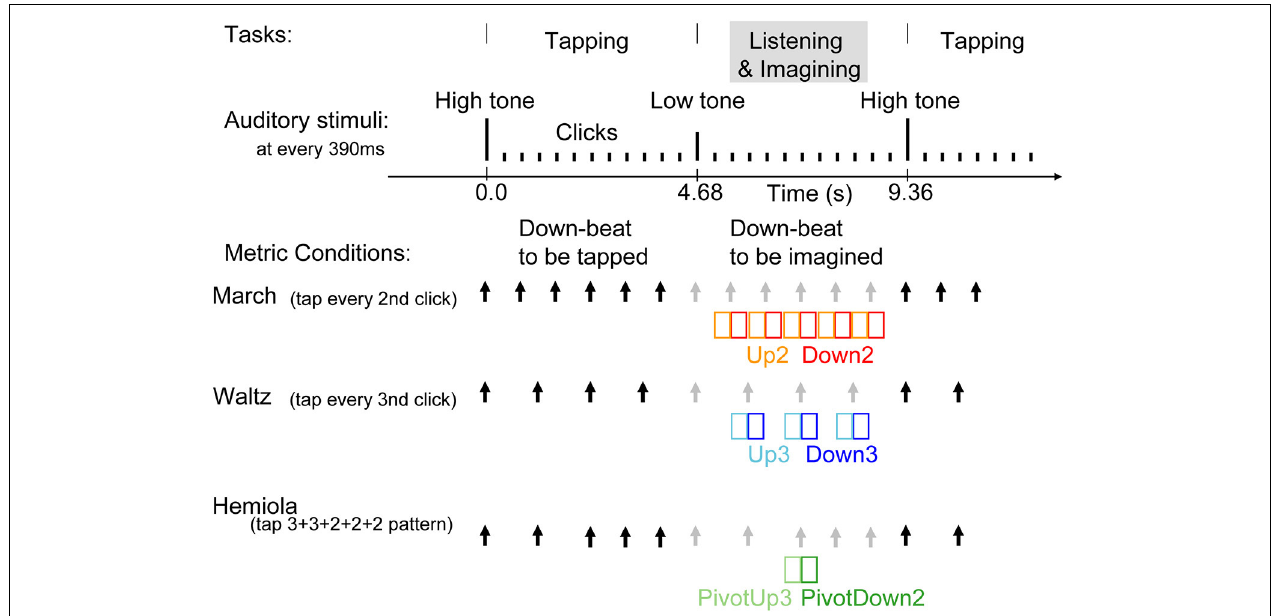
FIGURE 2 | Stimulus sequence and tasks. Auditory stimuli were 25ms tones presented every 390ms. Changes in pitch cued the beginning and the end of the tapping interval. The same stimulus was used for all three conditions. At a high-pitched 1000-Hz tone, the participants started tapping at every second tone in the march condition, at every third tone in the waltz condition, or twice in every third tone, followed by three times in every second tone, in the hemiola condition. The three conditions were run in separate experimental blocks. The black arrows indicate the downbeats with